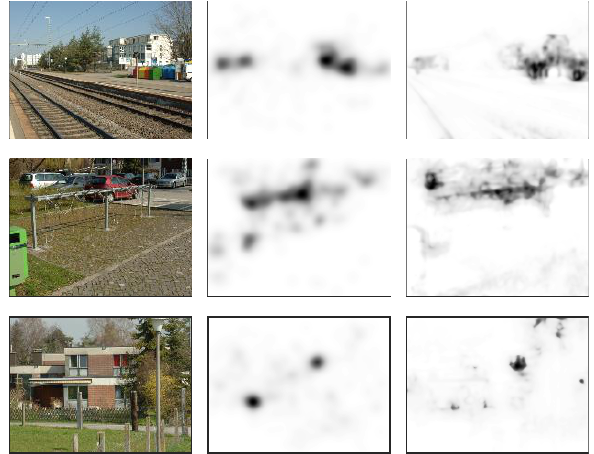
Figure 3. The different columns show a comparison of predictions by a simple saliency model (middle) on a variety of visual stimuli (left) to ground truth experimental data